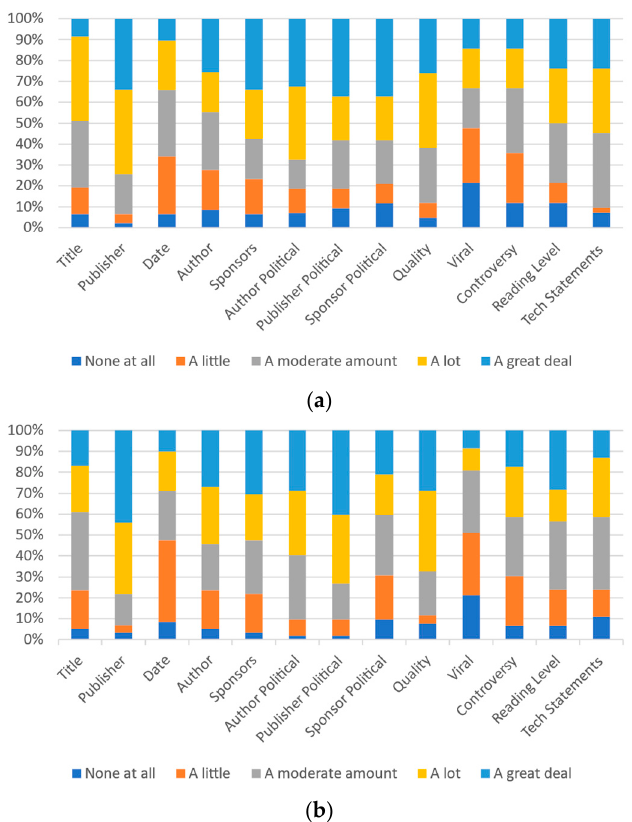
Figure 5. Participants’ responses on the magnitude of each category’s effect on self-perception: ( a ) University A and ( b ) University B.